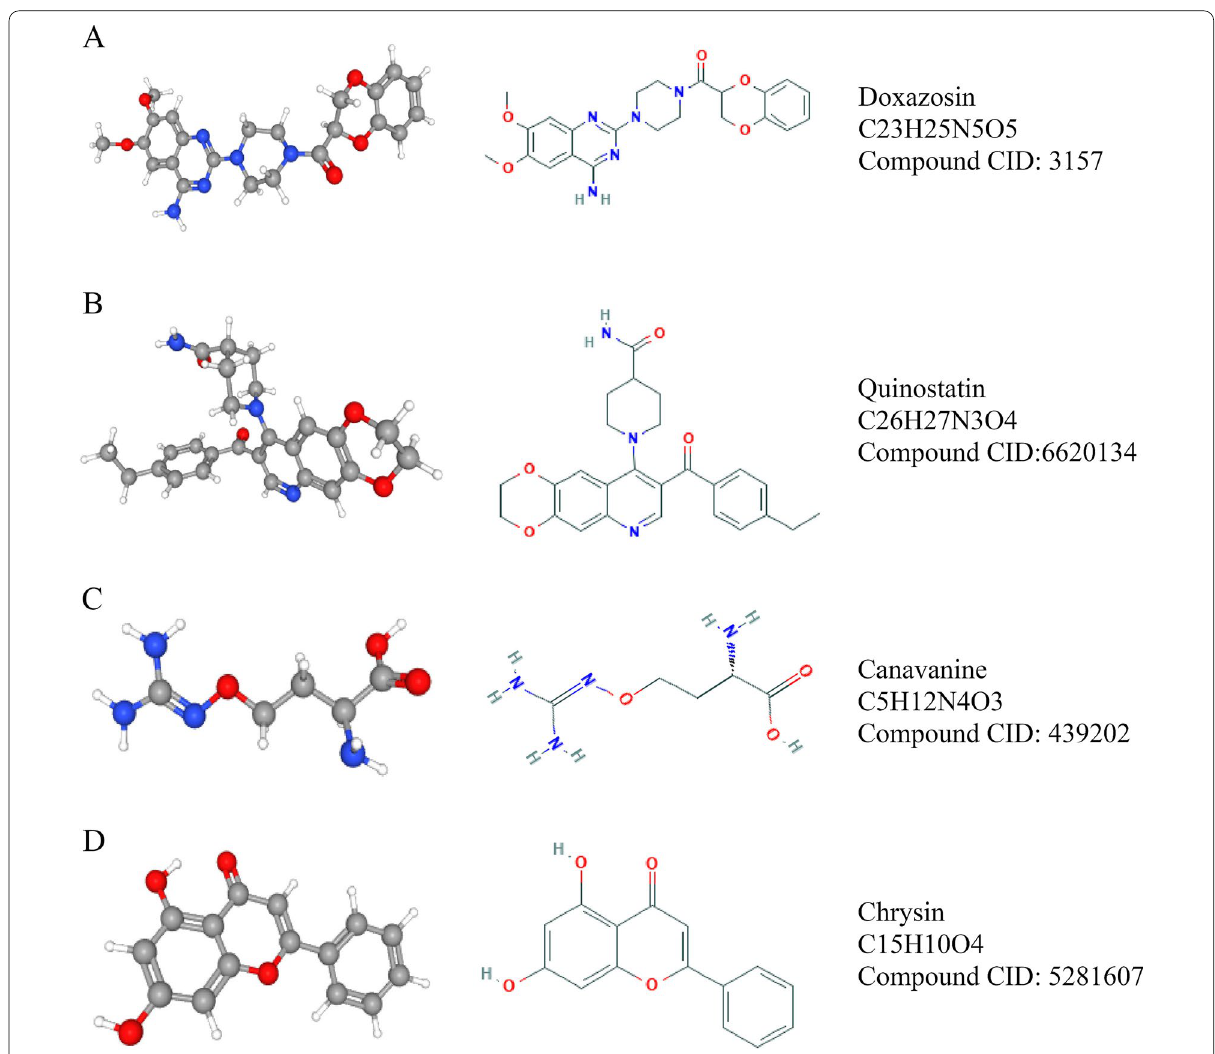
Fig. 6 Information regarding small molecules that target XRCC2 . A Doxazosin; B Quinostatin; C Canavanine; and D